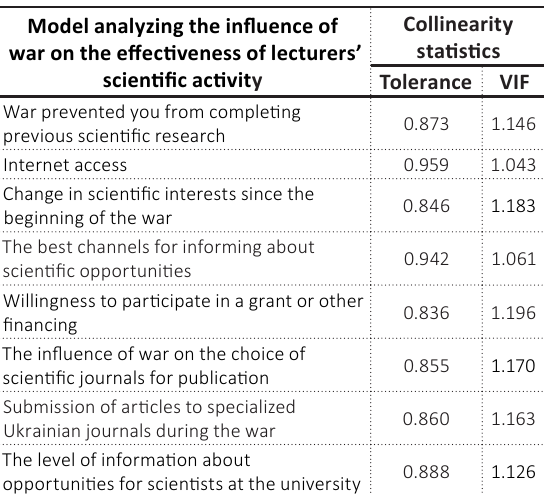
Table 1. Multicollinearity check of the research